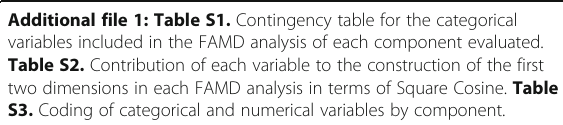
Table S2. Contribution of each variable to the construction of the first two dimensions in each FAMD analysis in terms of Square Cosine. Table S3. Coding of categorical and numerical variables by